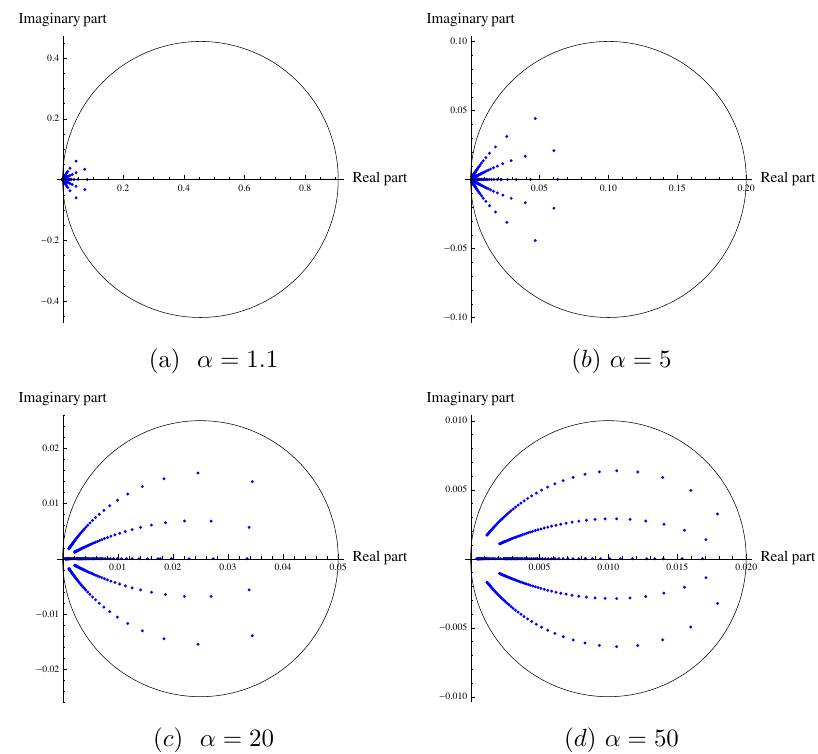
Figure 3. Eq. (4.4); Eigenvalues of D i , i = 1 , 2 ,... ; five degree spline collocation case with Chebyshev